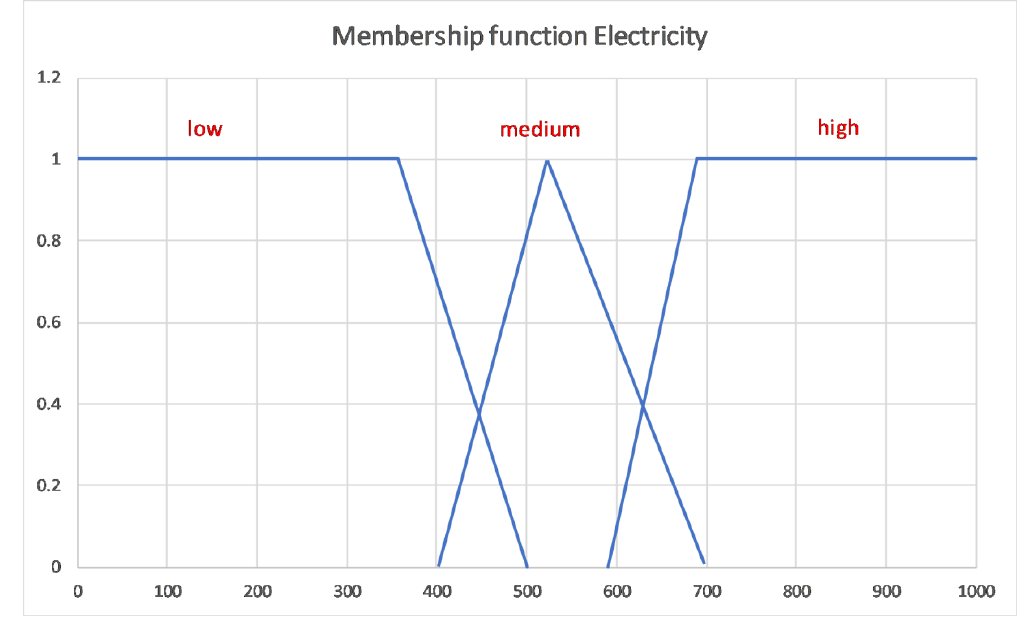
Figure 6. Membership function electricity.